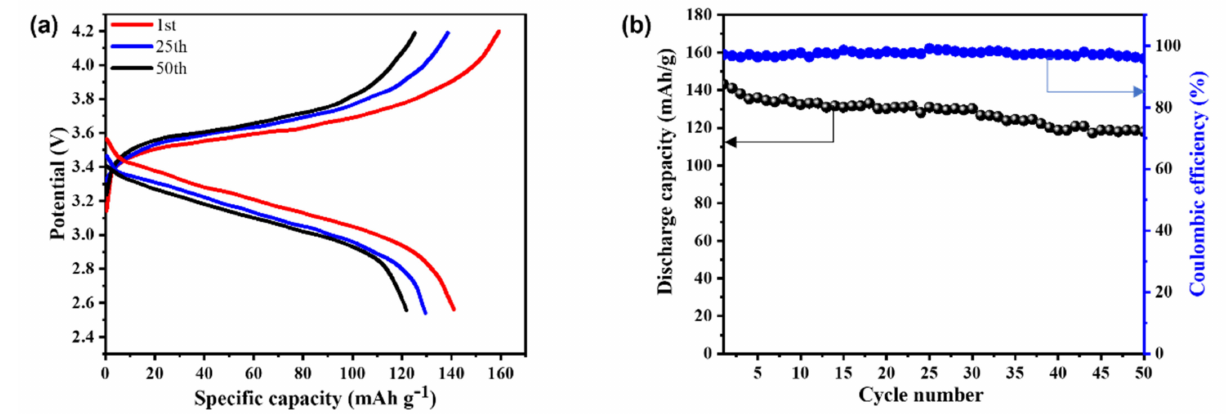
Figure 7. CD plots of SPE-2.5 with structure of LiFePO4/SPE-2.5/Li cell for 0.1 C over a potential range of 2.5–4.2 V at 25 ◦ C ( a ), discharge capacity and coulombic efficiency of CD cycling number of the LiFePO4/SPE-2.5/Li cell at 0.1 C and 25 ◦ C ( b ).